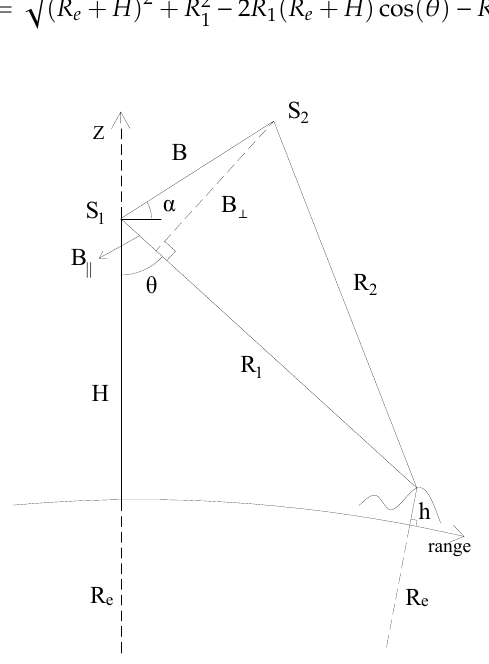
Figure 1. Imaging geometry of an InSAR system. The azimuth perpendicular to the page.